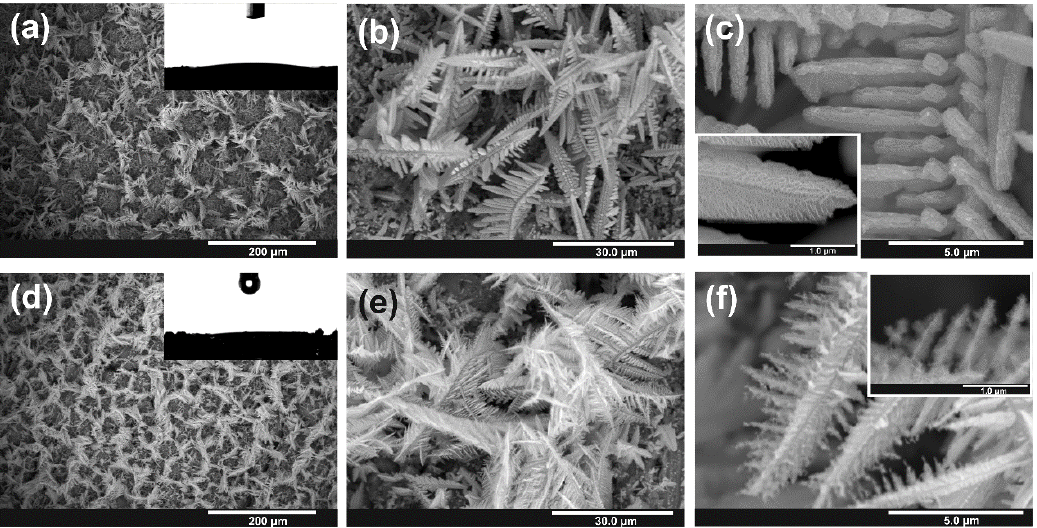
Figure 4. FE-SEM images of anodic Sn / SnOx anodized at 4 V for 600 s ( a – c ), and 1200 s ( d – f ) after annealing in air at 200 °C for 2 h.